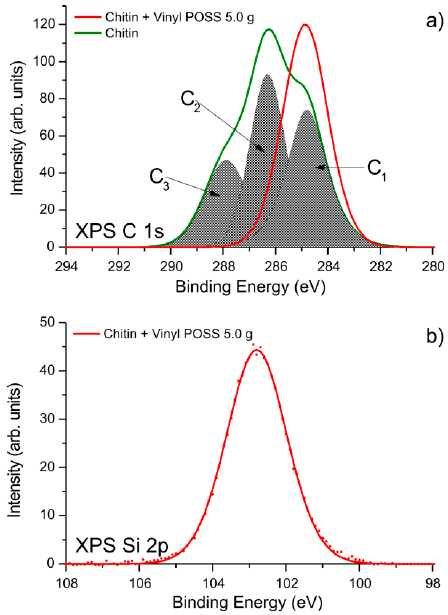
Figure 1. ( a ) C 1s spectrum for chitin and chitin-vinyl POSS hybrid; ( b ) Si 2p spectrum for chitin-vinyl POSS hybrid.